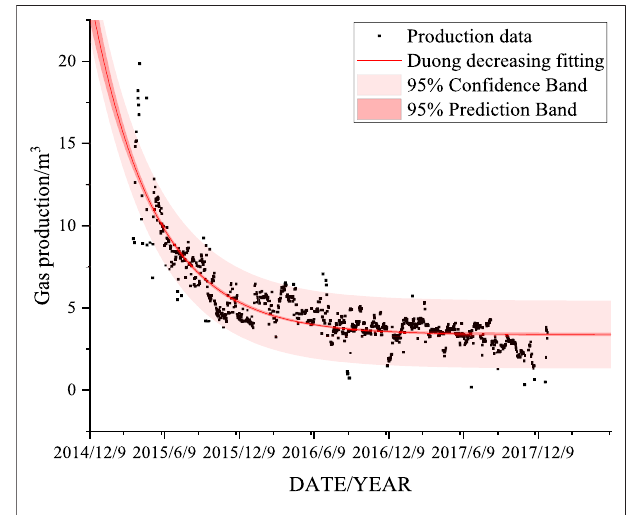
FIGURE 13 | Well production in block-A before